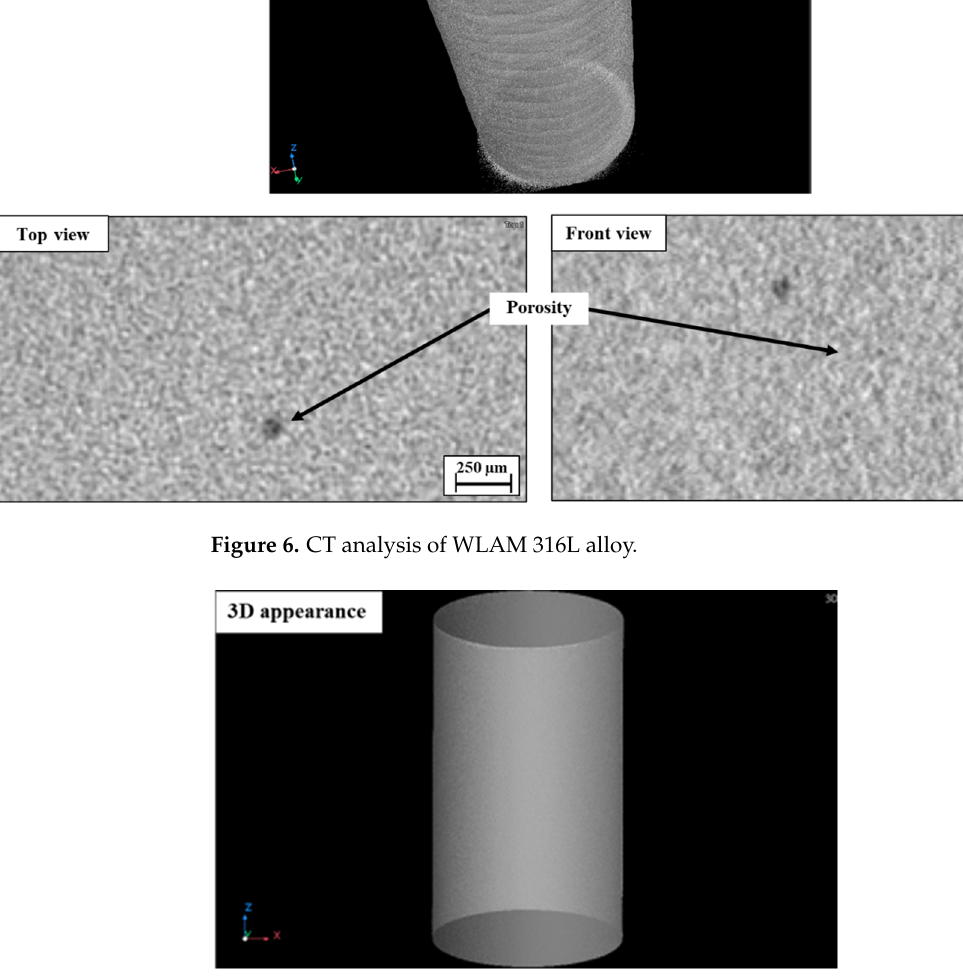
Figure 7. CT analysis of counterpart AISI 316L alloy. Table 1. The pitting density and pitting factor of WLAM 316L and its counterpart AISI 316L alloy